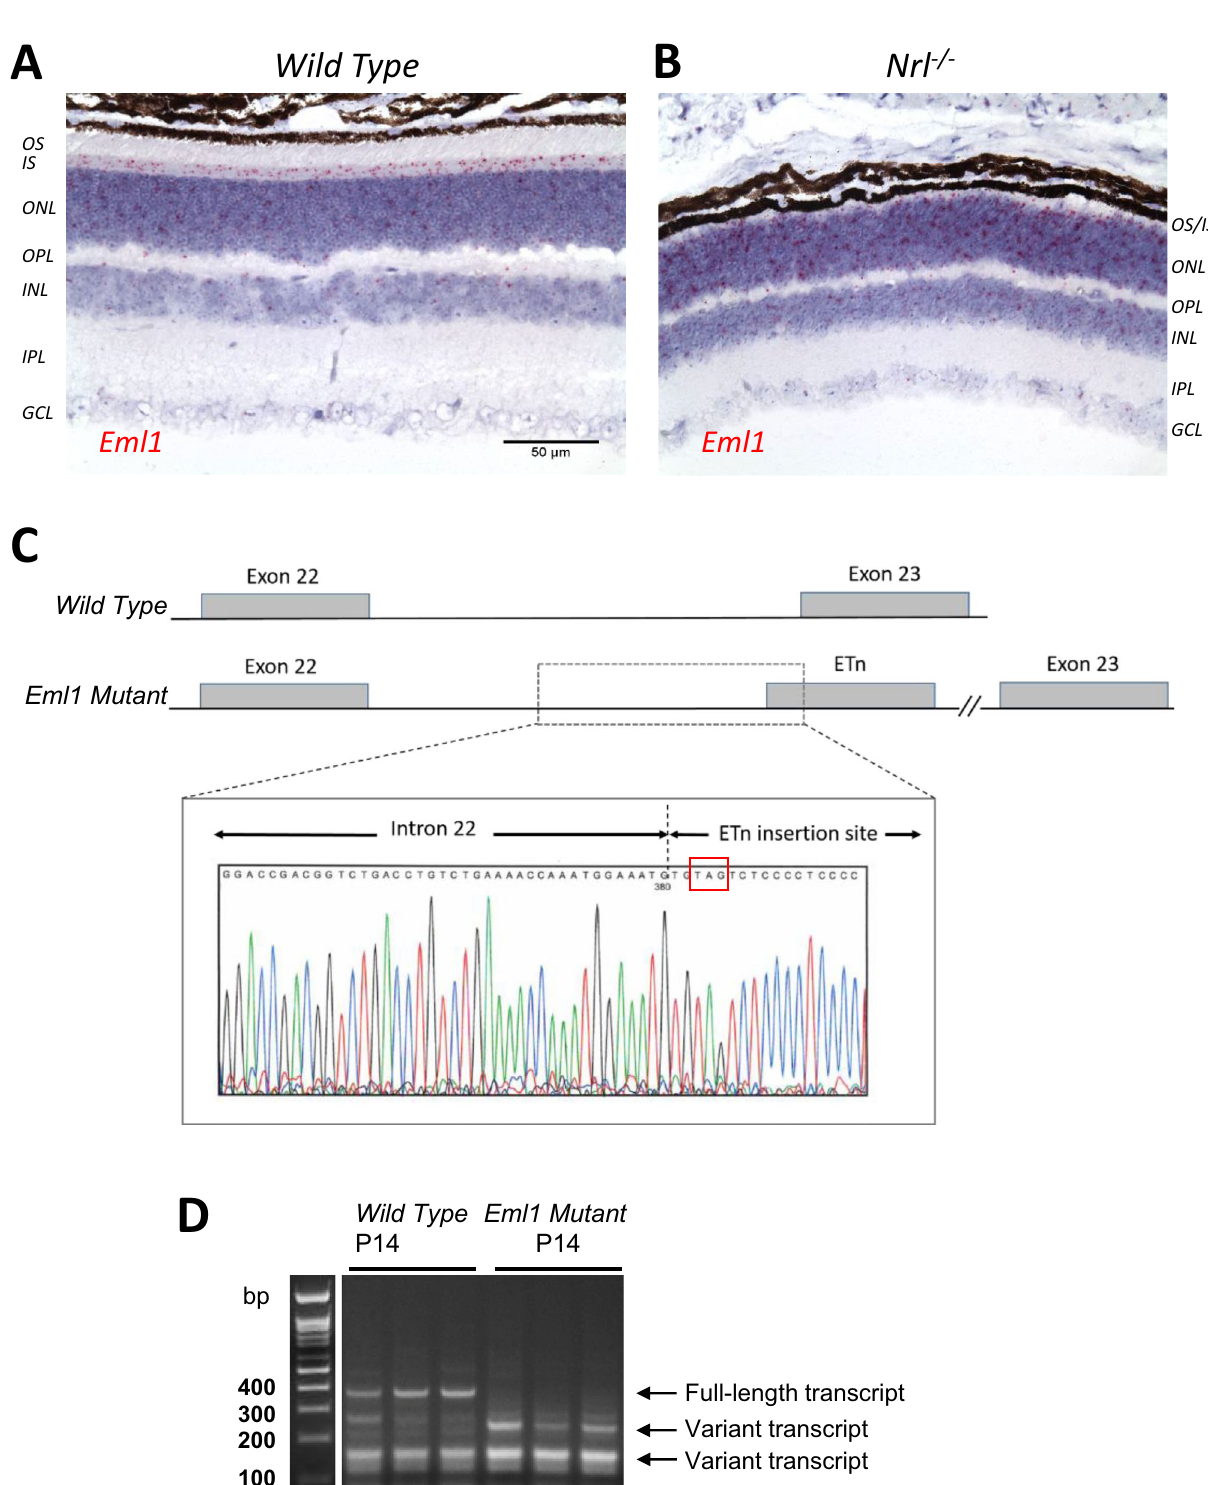
Figure 1. Expression of Eml1 in mouse retina. In-situ hybridization showing the expression of Eml1 in photoreceptors of 8 week-old wild type mouse retina ( A ) and age matched cone-only ( Nrl −/− ); ( B ) retina. The scale bar applies to both panels. outer segments (OS) and inner segments (IS) of photoreceptors, outer nuclear layer (ONL), outer plexiform layer (OPL), inner nuclear layer (INL), inner plexiform layer (IPL) and ganglion cell layer (GCL). ( C ) Location of the mutation (represented by an early retrotransposon, ETn) insertion site in the mutant Eml1 gene in the intron 22. The sequence at the insertion site is magnified to show the location of the premature stop codon TAG ( highlighted in red box ) in the gene ( C , inset ). ( D ) RT-PCR from P14 wild type and age matched Eml1 mutant mice (the marker lane is from the same gel, see supplementary Fig.